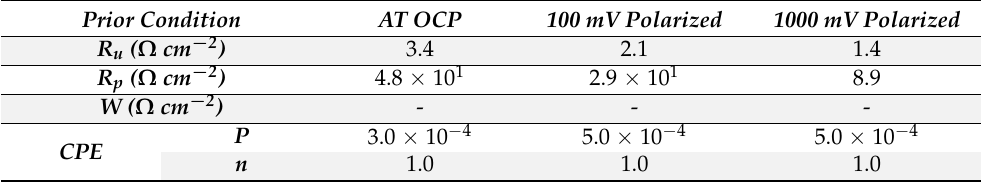
Table 7. Impedance spectra results after fitting with equivalent circuit